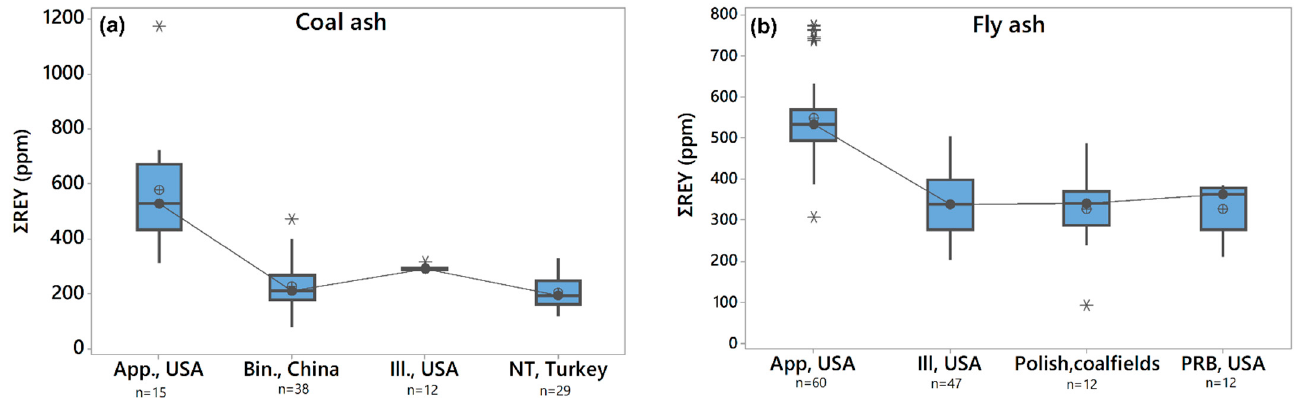
Figure 1. ( a , b ) Boxplots of RE Υ concentrations for coal ash and fly ash, respectively, from different coal basins: Appalachian (App. USA), Illinois (Ill. USA), Powder river coal basin, USA [23], Binxian (Bin., China) [22], Northwest Thrace coal basin (NT, Turkey) [27], Polish coalfields [13] (*: outlier values) .